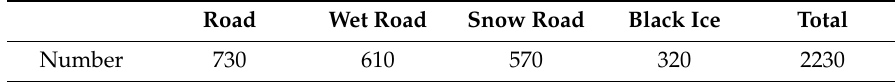
Table 1. The Number of Image Data.